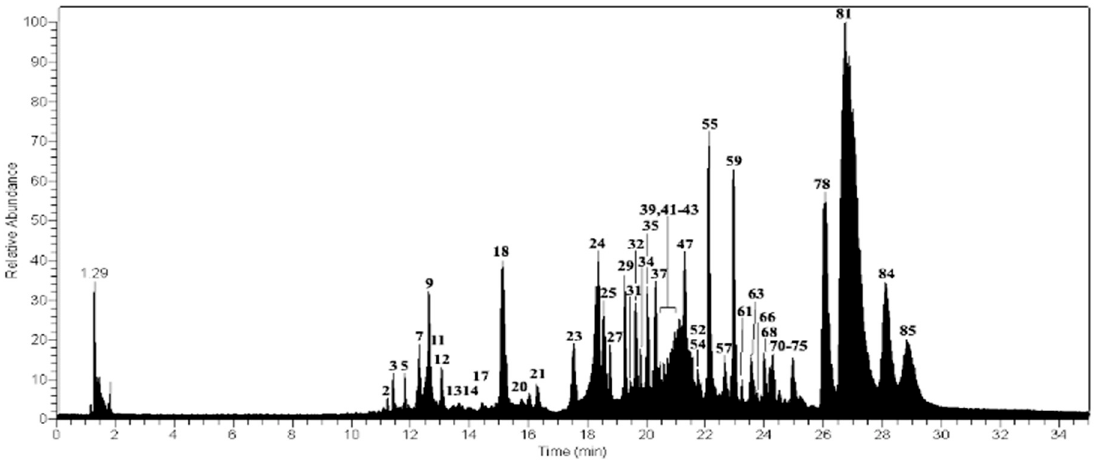
Figure 4. UHPLC-MS Chromatogram of U. subfloridana .